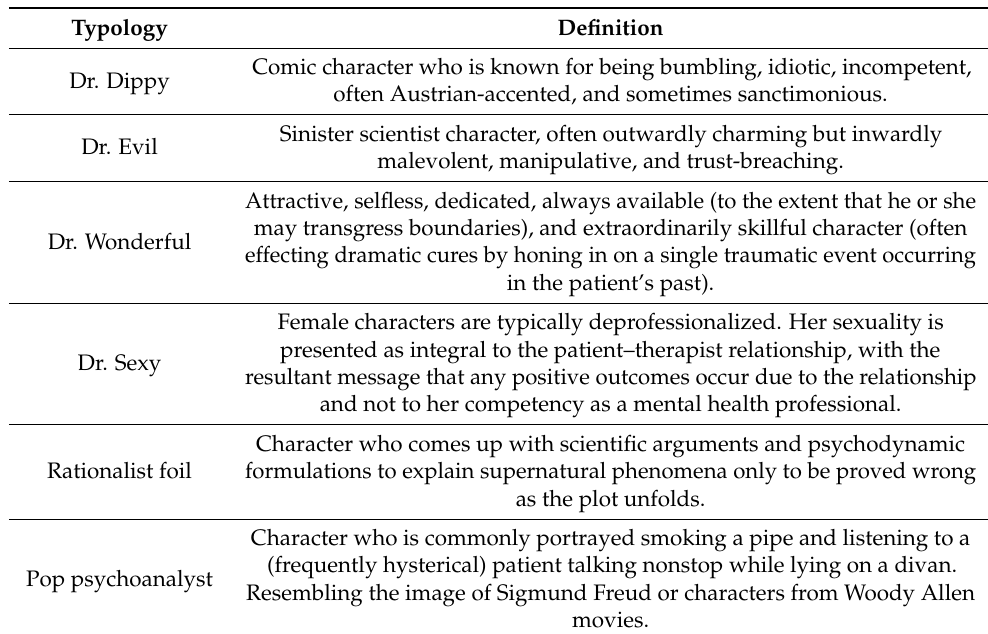
Table 2. Typology of psychiatrists. Sources: Schneider (1987), Pirkis et al. (2006), and Estrada